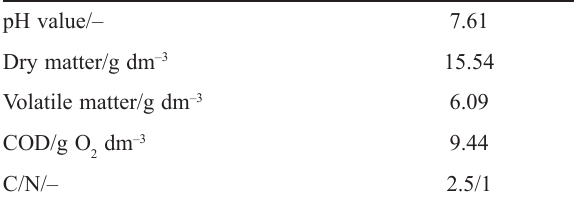
Table 2 – Initial characterisation of